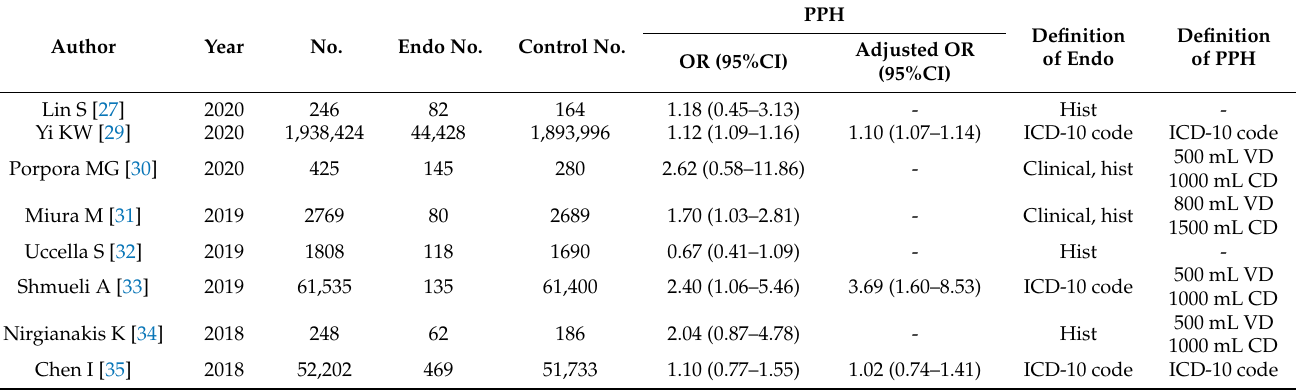
Table 4. Comparator analysis of the rates of PPH between women with and without